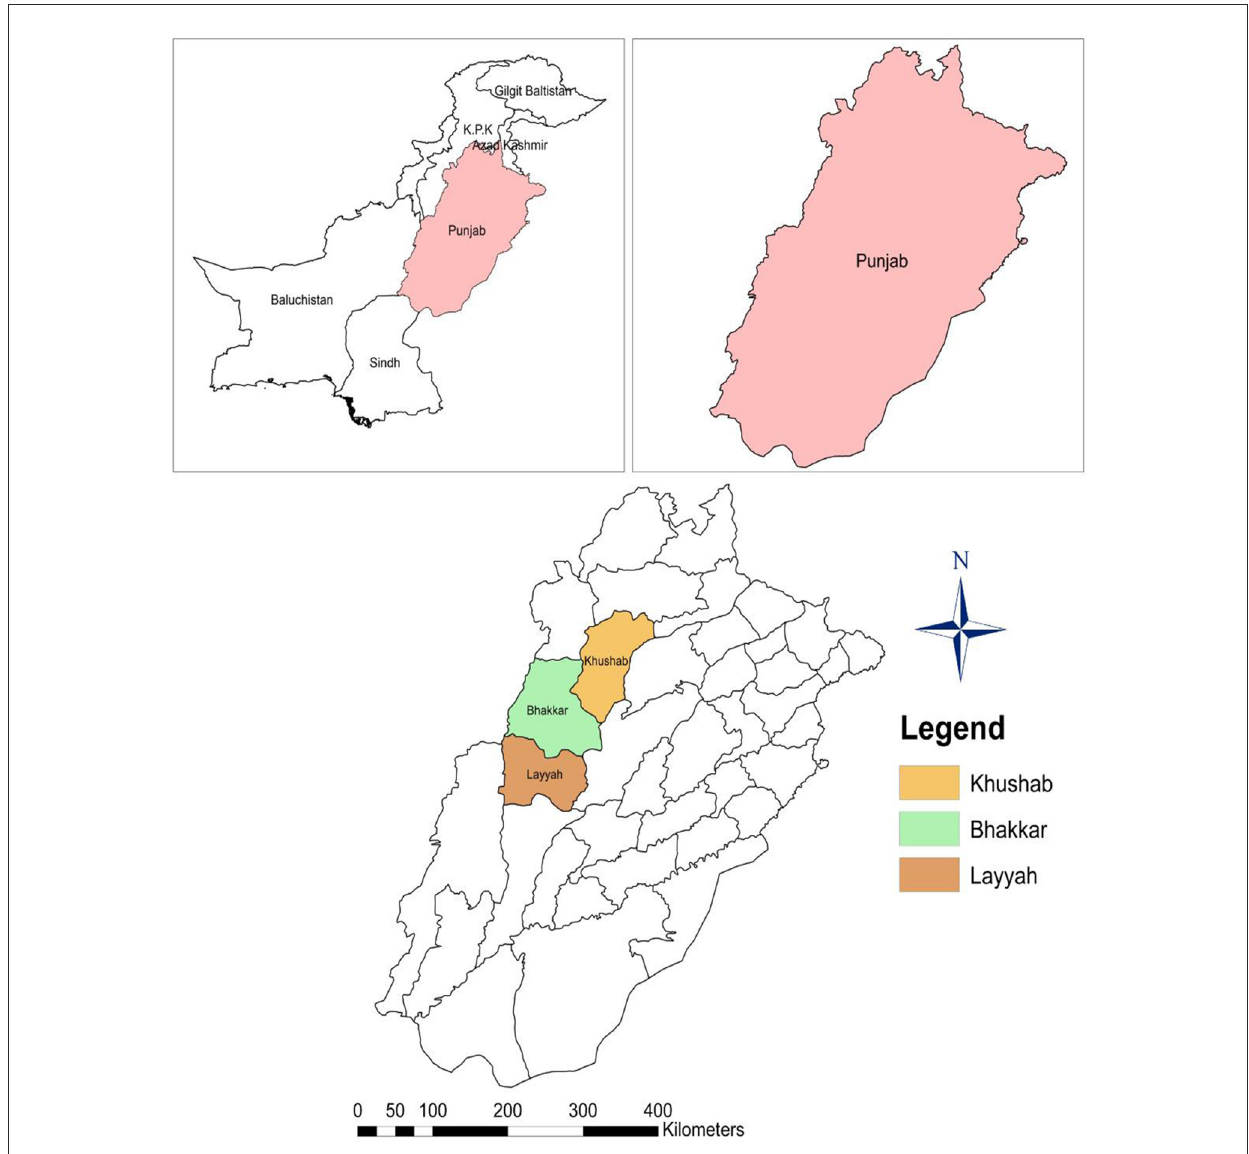
FIGURE1 A map of Punjab, districts for this study in Pakistan.